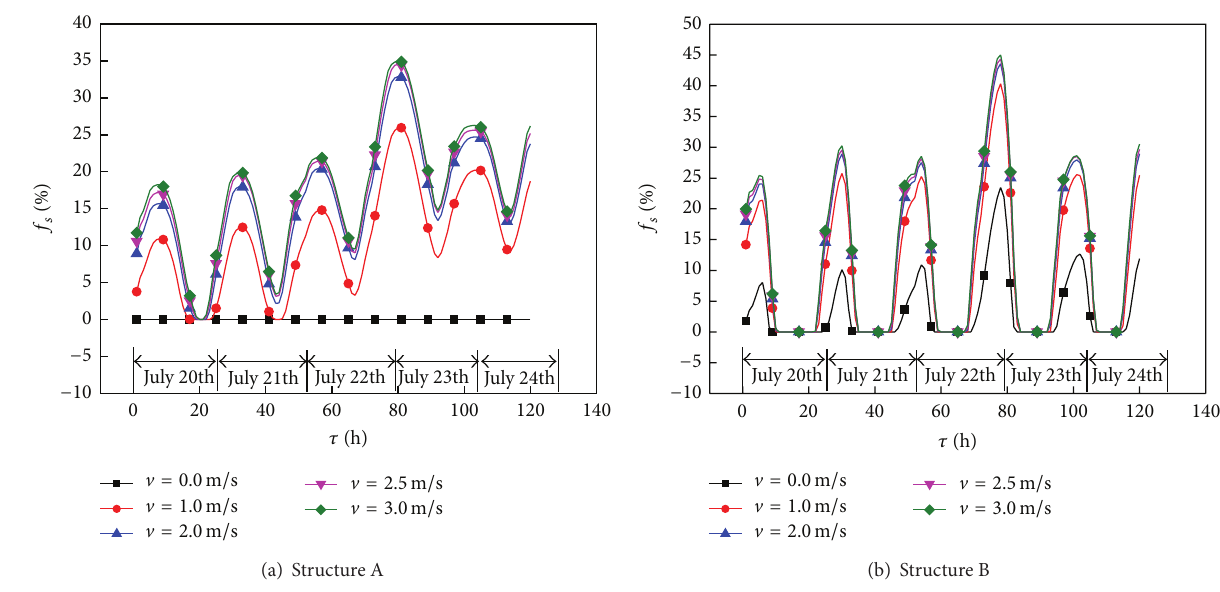
Figure 7: Contrast pictures of solid fraction of inner surface in different structure with several